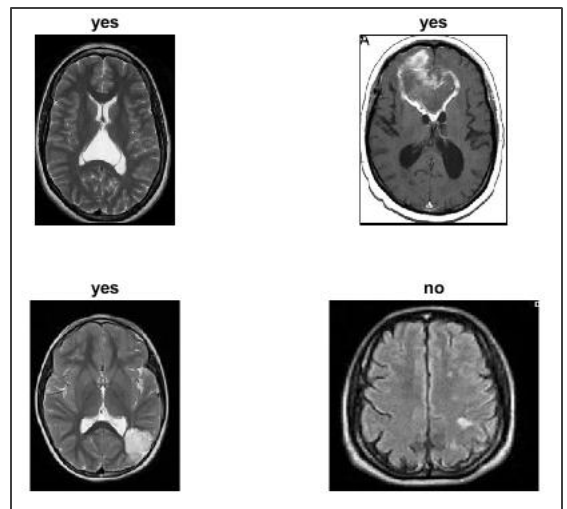
Figure 13. Sample images from the MRI brain dataset.